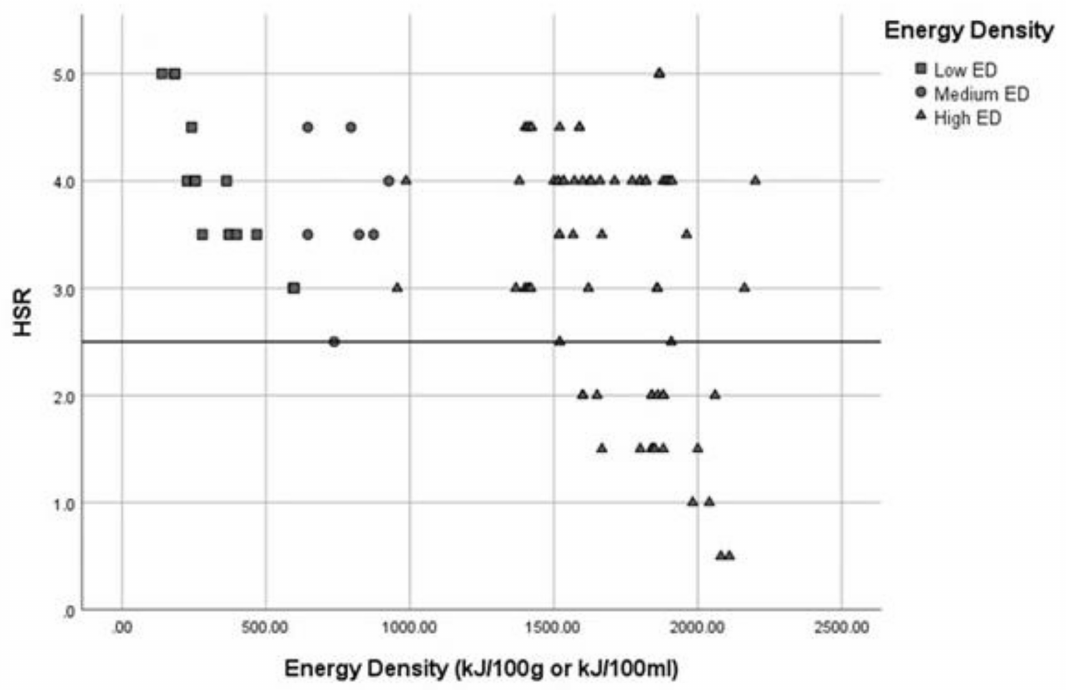
Figure 1. Scatterplot of product Health Star Rating (HSR) by low, medium and high energy density